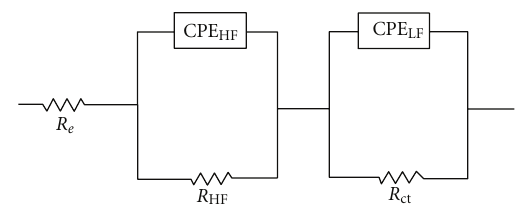
Figure 5: Equivalent electrical circuit (EEC) used to fit impedance data for low-nickel SS rebar embedded in mortars A and B with di ff erent chloride